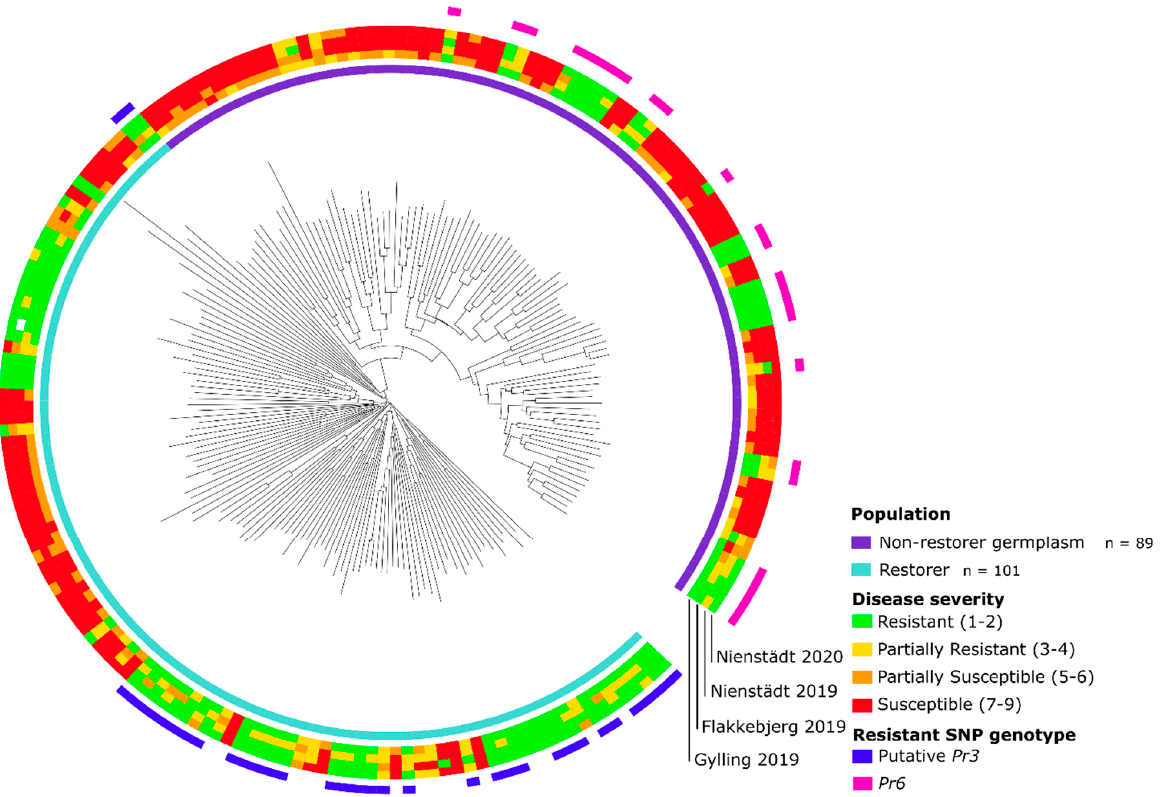
Figure 2. Circular neighbor ‐ joining dendrogram of 180 hybrid rye ( Secale cereale L.) breeding lines using 261,406 informative SNP markers. Leaf rust resistance (1–9) at four field trials in Denmark and Northern Germany in 2019 and 2020 displayed by concentric circles around the dendrogram. Lines carrying the resistant genotype of single ‐ nucleotide polymorphism (SNP) markers associated with leaf rust resistance gene on chromosome arm 1RS (putative Pr3 ) and 7RS ( Pr6 ) are likewise displayed in the concentric circles.